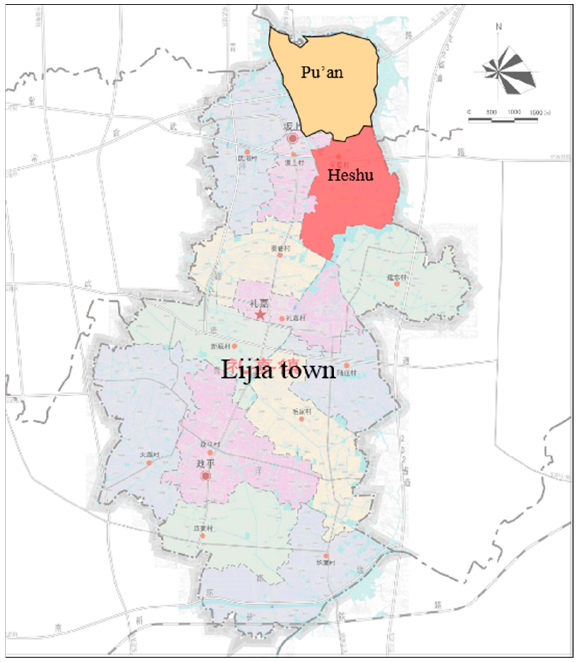
Figure 1. Location of Heshu village and Pu’an village in Lijia town.